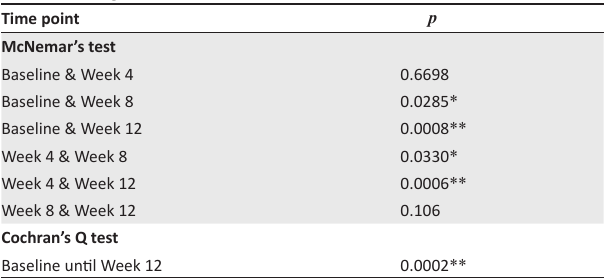
TABLE 4: Change in condom use.